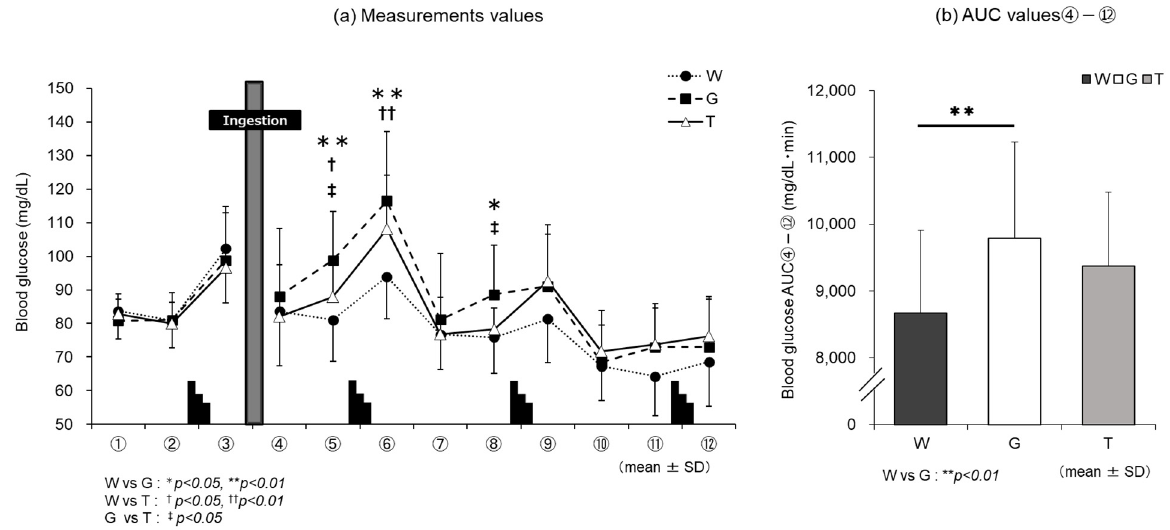
Figure 4. Changes in blood glucose levels for each trial. W—water; G—glucose; T—trehalose. Changes in blood glucose levels in each trial (water (W), glucose (G), trehalose (T)). Comparison between ( a ) measurements and ( b ) area under the curve (AUC) values ④ – ⑫ of each trial. ( n = 12); W vs. G: * p < 0.05, ** p < 0.01; W vs. T: † p < 0.05, †† p < 0.01; G vs. T: ‡ p < 0.05. Figure 5. Changes in insulin levels for each trial. W—water; G—glucose; T—trehalose. Changes in insulin levels in each trial (water (W), glucose (G), trehalose (T)). Comparison between ( a ) measurements and ( b ) area under the curve (AUC) values ④ – ⑫ of each trial ( n = 12). W vs. G: * p < 0.05, ** p < 0.01; W vs. T: † p < 0.05 , †† p < 0.01; G vs. T: ‡ p < 0.05.